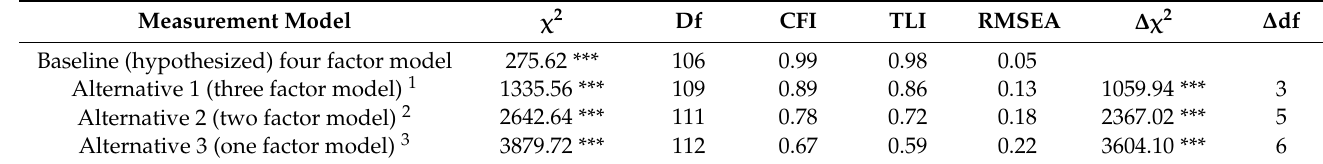
Table 3. Model fit statistics for the measurement